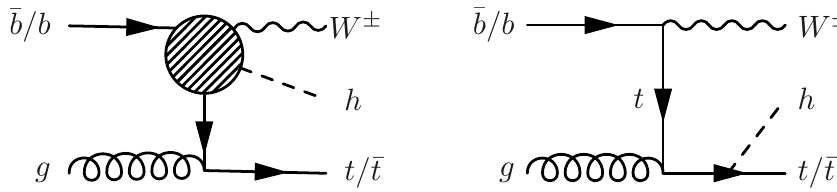
Figure 15. Left : schematic Feynman diagram for the thW process embedding the b W subamplitude. Right : Feynman diagram for the contribution to thW that does not embed the subamplitude of